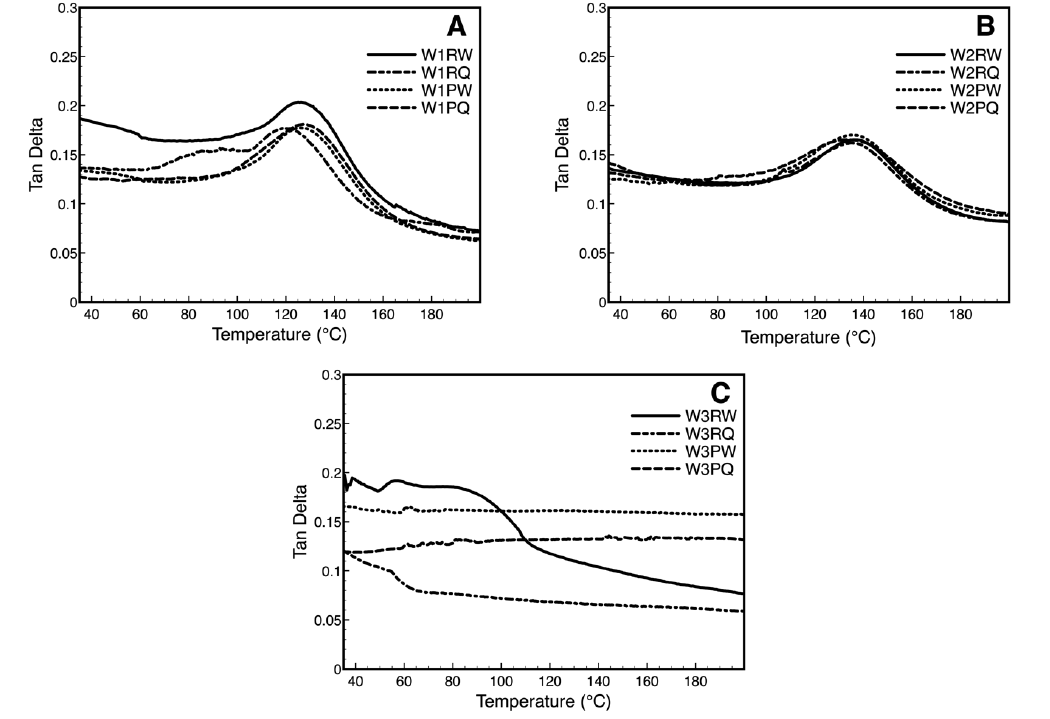
Figure 6. Temperature dependence at 4 Hz of tan delta of W1 ( A ), W2 ( B ), W3 ( C ) of untreated (R) and plasma-treated samples (P) at Day 7 immersed in water and ADBAC.